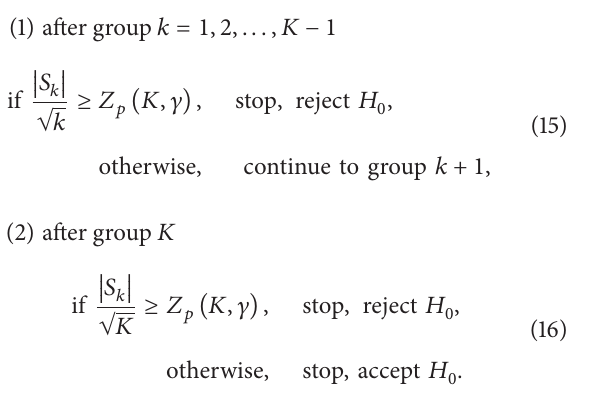
Table 1: Pocock’s critical values 𝑍 𝑝 (𝐾,𝛾) and Δ for two-sided test, 𝐾 = 1, ...,5 ; 1 − 𝛽 = 0.95 ; 𝛾 = 0.10